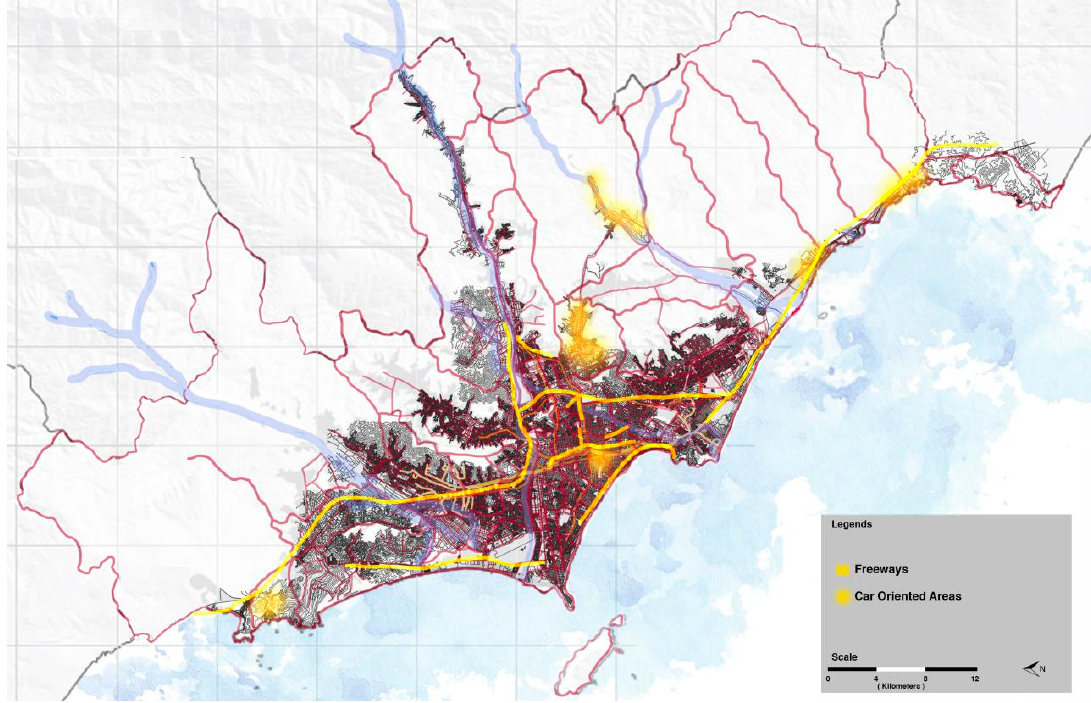
Figure 6. Lima’s freeway system (Panamericana Fwy. is the only one that traverses the city). Source: References [13,43]. Map by authors.